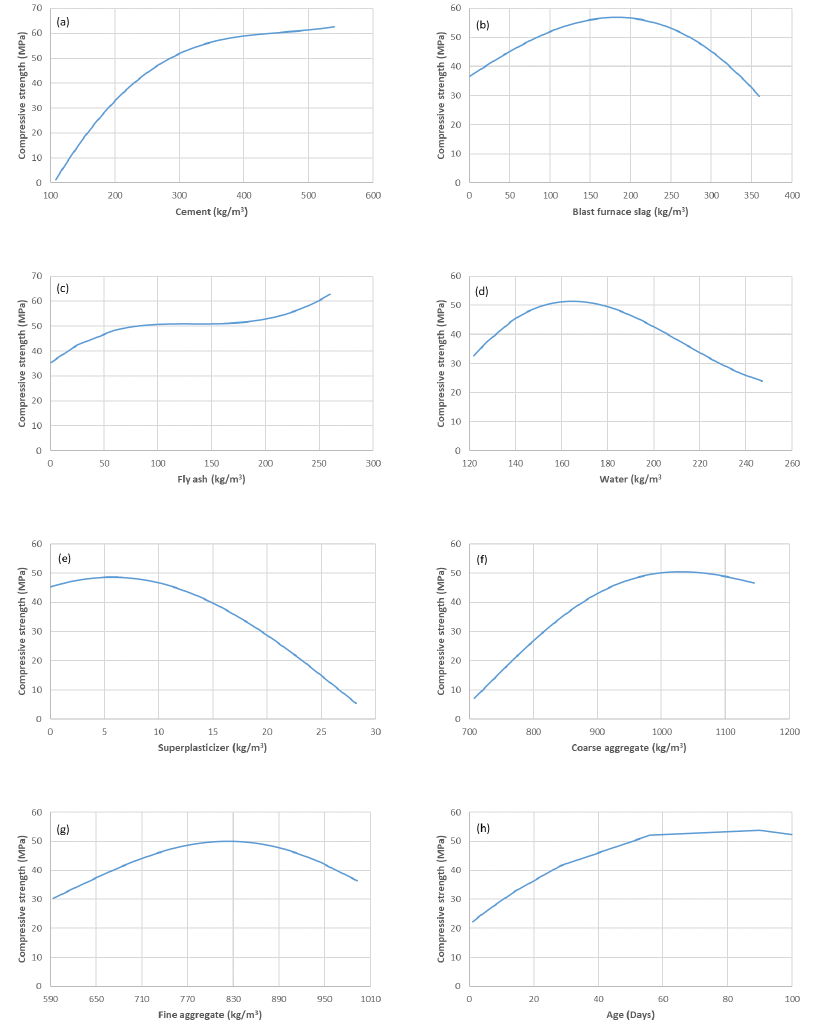
Figure 9. Sensitivity analysis of the developed RELM